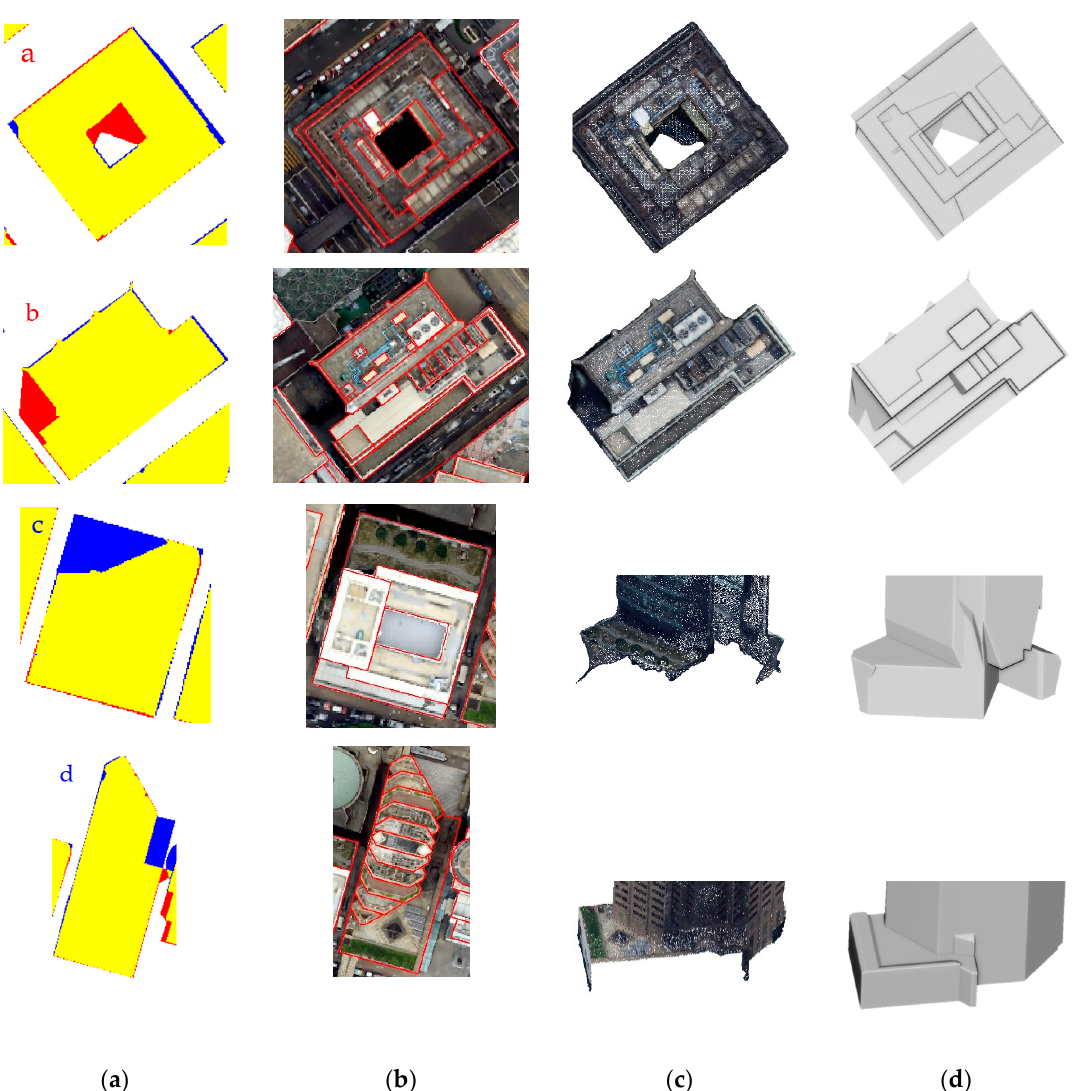
Figure 21. Detailed reconstruction results of buildings with false surface detections. From top to bottom are the false detections pointed by arrows a ~ d in Figure 20. ( a ) 2D comparisons between the generated models and the manually digitalized ground-truth; ( b ) The manually digitalized ground-truth overlapping on the ortho image; ( c ) The building point clouds where the false detections appeared; ( d ) The generated building models.